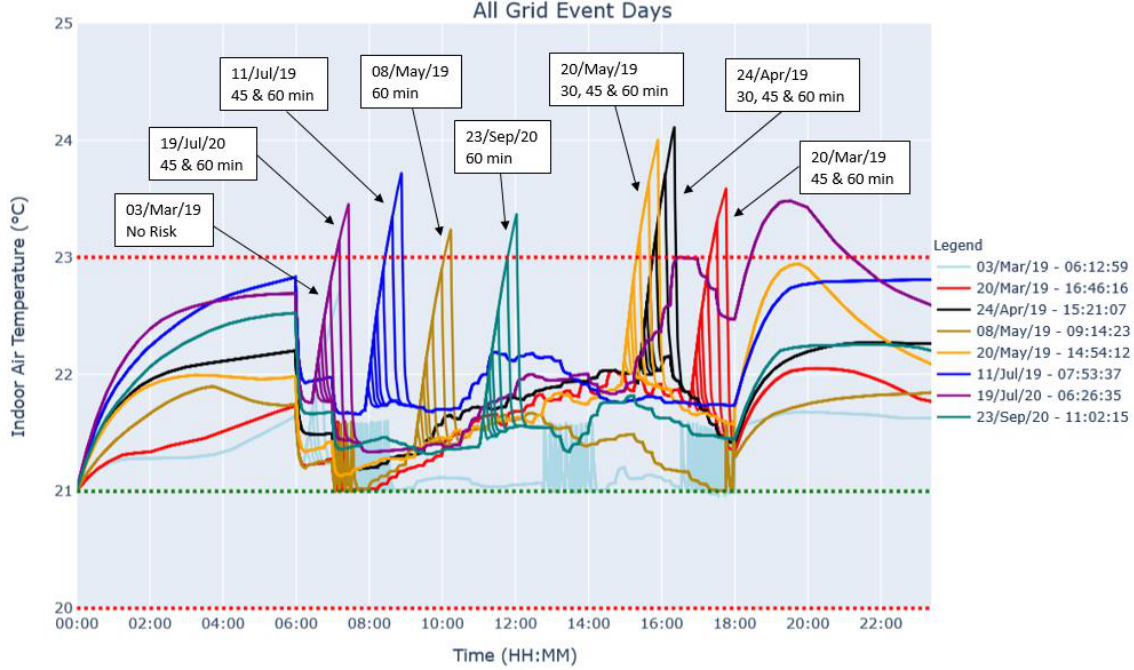
Figure 5. Overview of indoor air temperature within the zone for each grid frequency event day, demonstrating AHU performance over each of the shutoff durations, with red dashed lines depicting temperature limits.